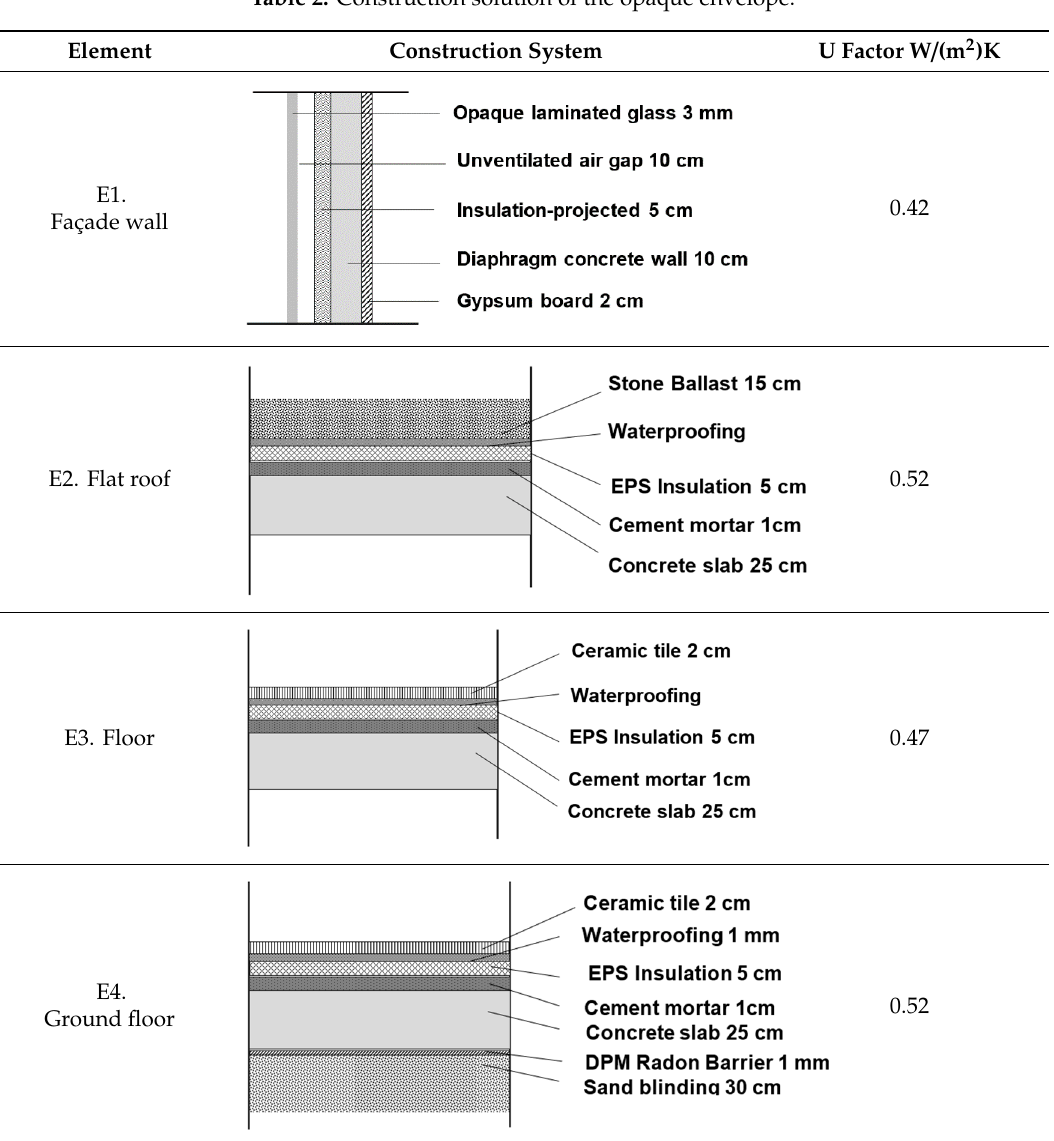
Table 2. Construction solution of the opaque envelope.